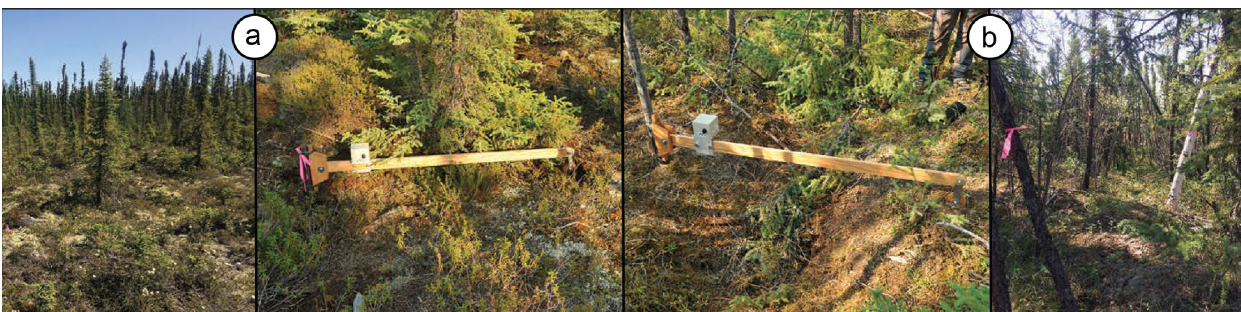
Figure 1. Overview images and close-up photographs of ground cover around tilt arms showing the character of the sites instrumented. Site Evil Peat (a) , similar to site Drill the Chill, is in a peatland with open black spruce and tamarack forest. Site Active Slayer (b) is in dense black spruce forest overlying hummocks in mineral soil.